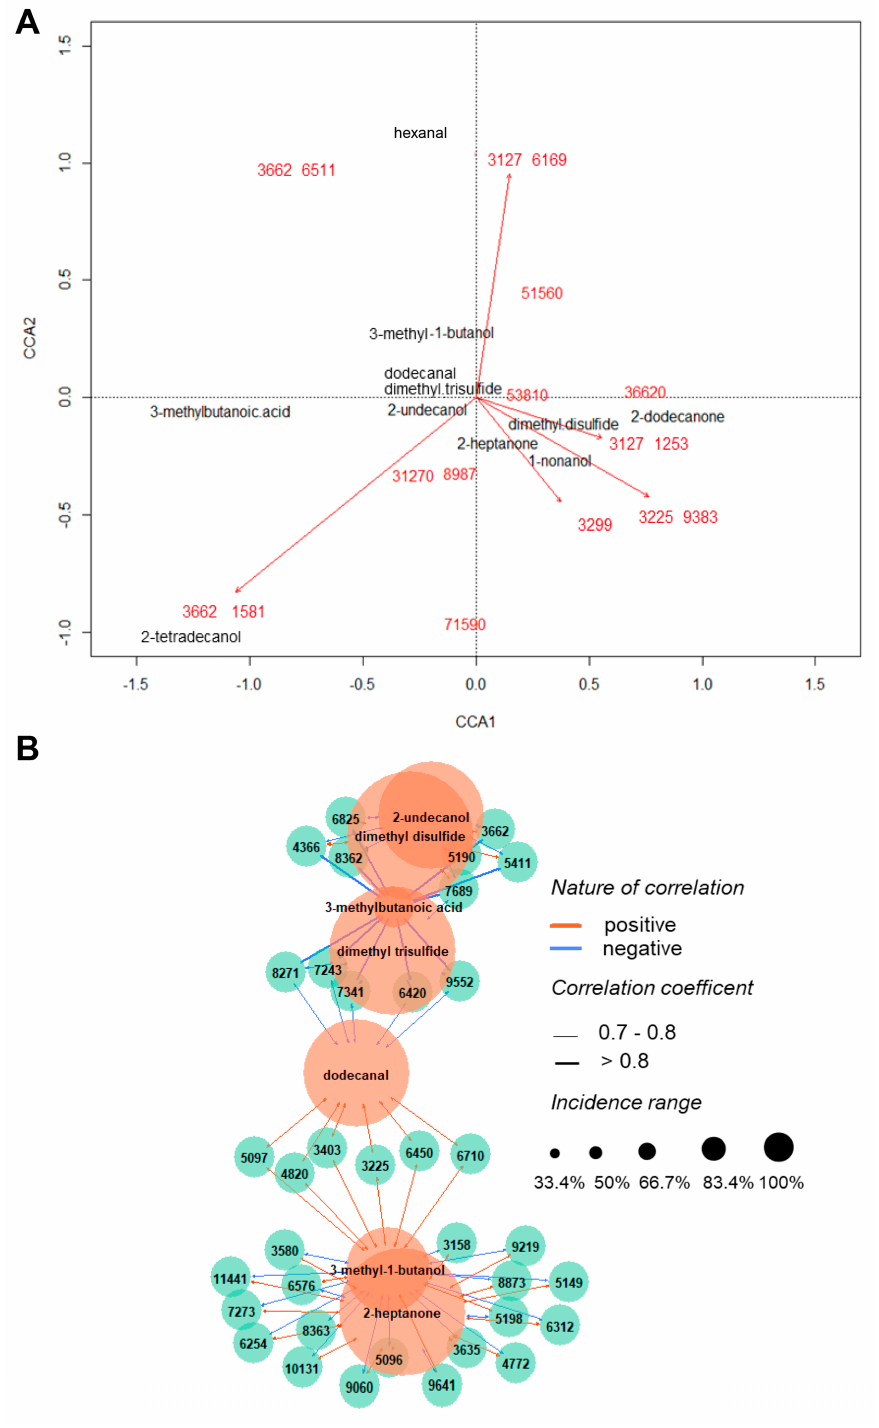
Figure 6. ( A ) Canonical correlation analysis (CCA) biplot showing the correspondence of the main protein ions (red) with emitted VOCs (black), where CCA1 = 22.43% and CCA2 = 15.28%; ( B ) Correlation network depicting main relevant connections (rho ≥ [0.7]) between MALDI-TOF MS ions and identified volatiles.